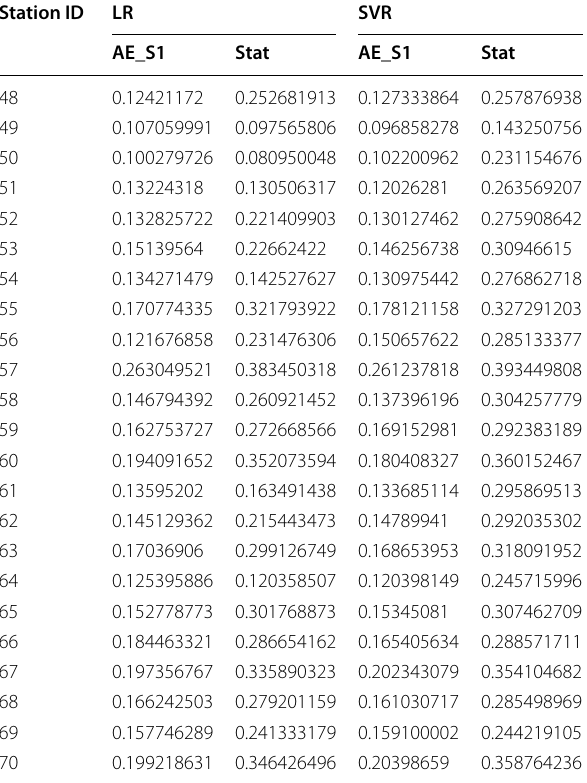
Table 2 Comparison of day-ahead prediction error